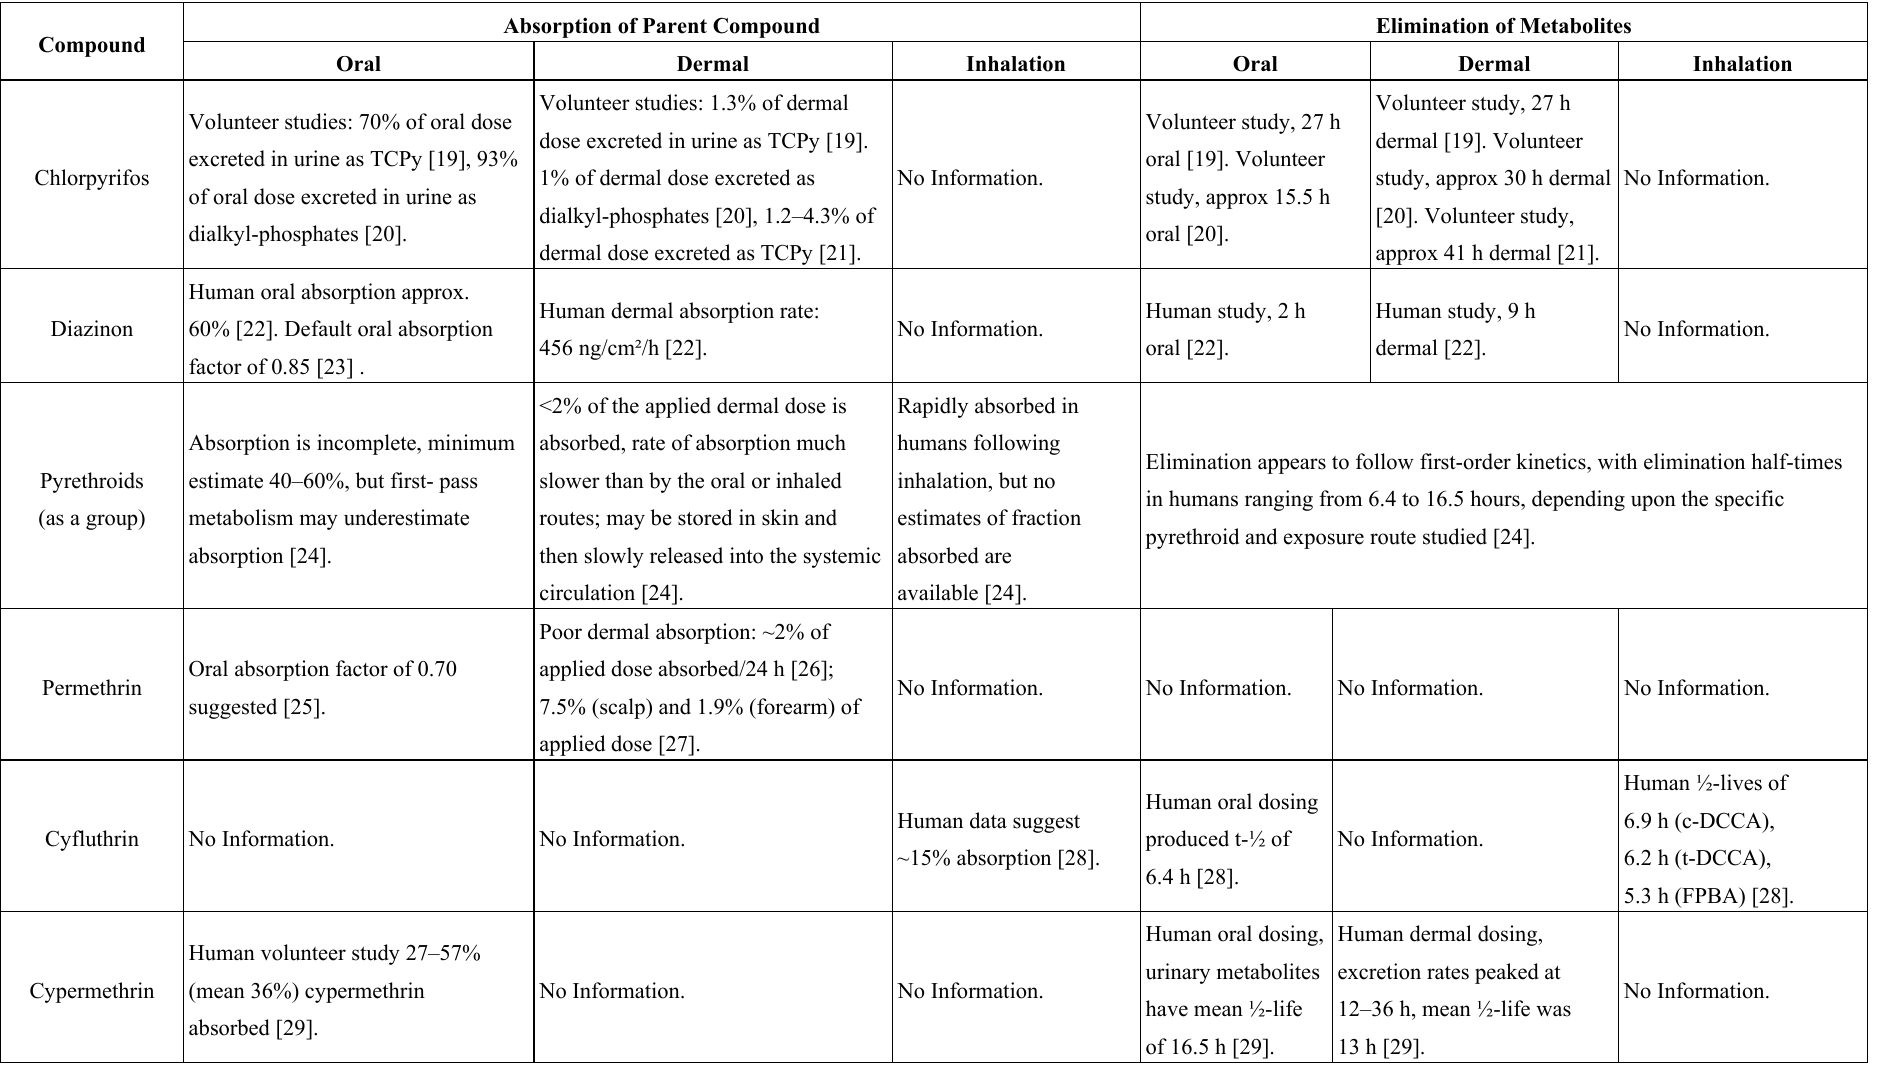
Table 1. Absorption and elimination characteristics for pesticides and urinary biomarkers of pesticide